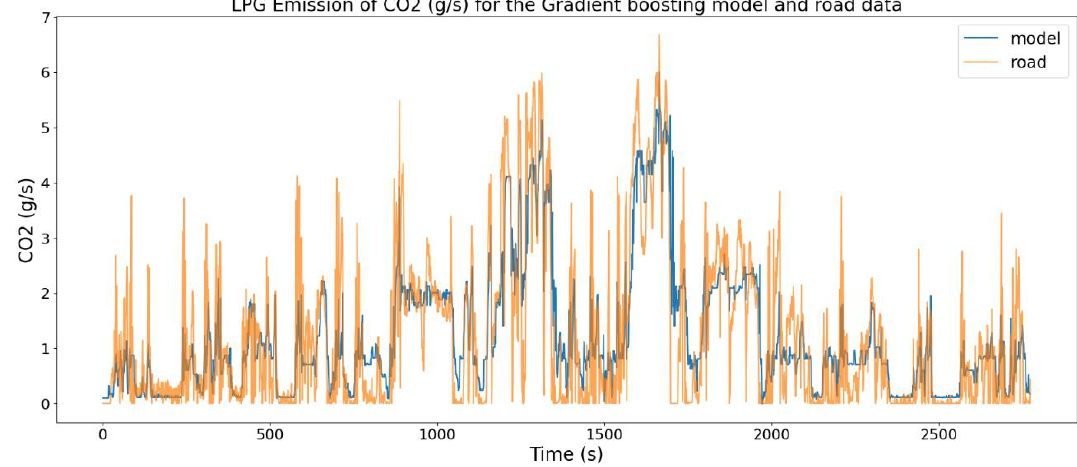
Figure 7. Instantaneous emission of CO 2 using LPG vehicles for model and road data.